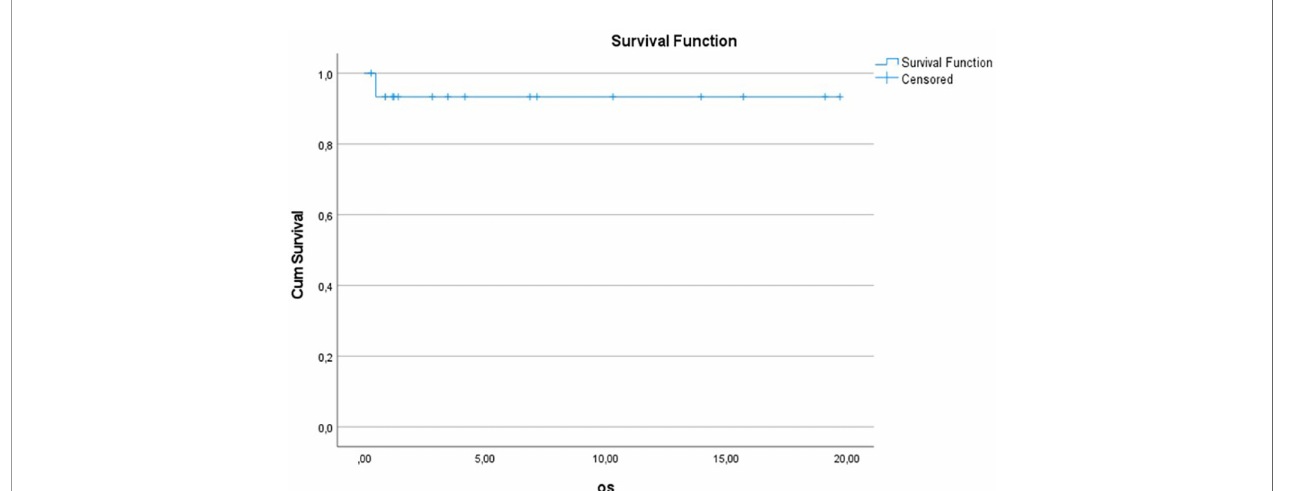
FIGURE 4.1 | Kaplan-Meier plot of OS for all patients with Gorlin syndrome (n=16).